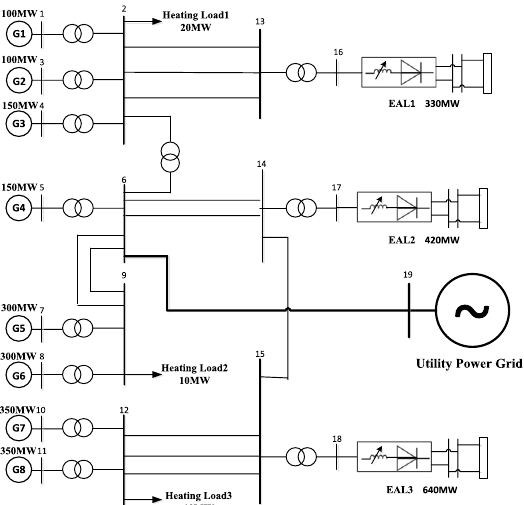
Fig. 7 The structure of an actual IMG with the EALs